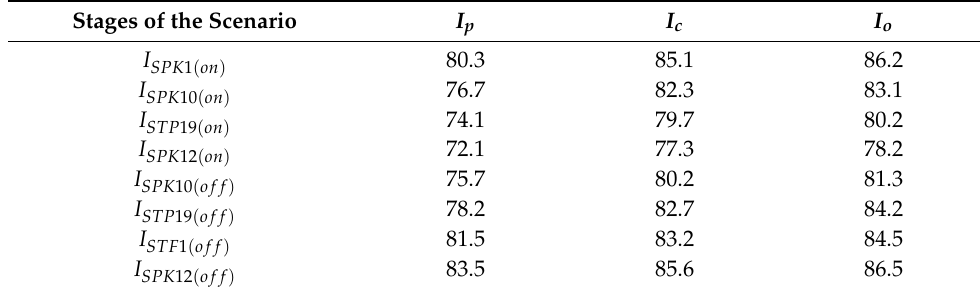
Table 5. Calculation of the asset resilience index for individual types of